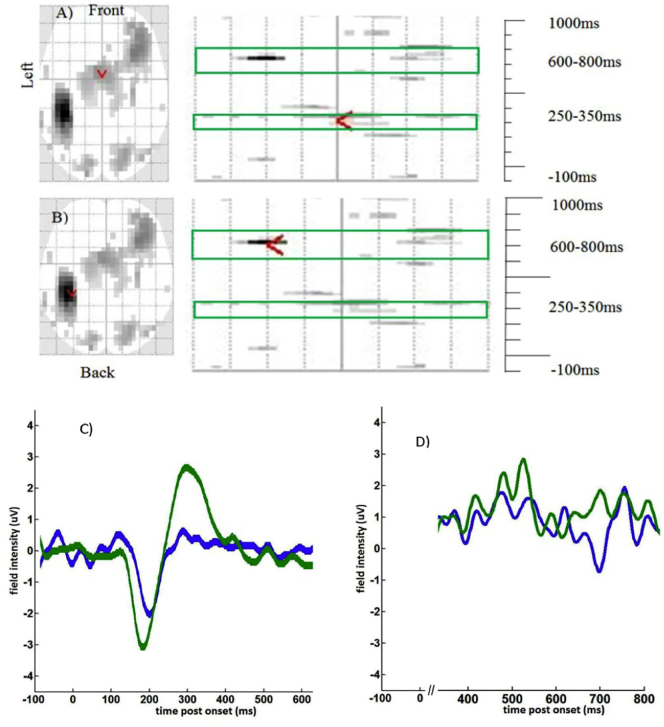
Results of F test difference between responses to own name and other names within the window of −100 ms to 1000 ms in per stimulus time. The red arrow indicates the most significant response from Healthy control subjects (n = 10), using an F test to contrast ‘own name’ against ‘others’ names' A) Early response 250–350 ms (midline frontal), B) Late response 600–800 ms, (left superior parietal), C) ERP response 250–350 ms to own name-blue line and other names-green line, D) ERP response 600–800 ms to own name-blue line and other names-green line.